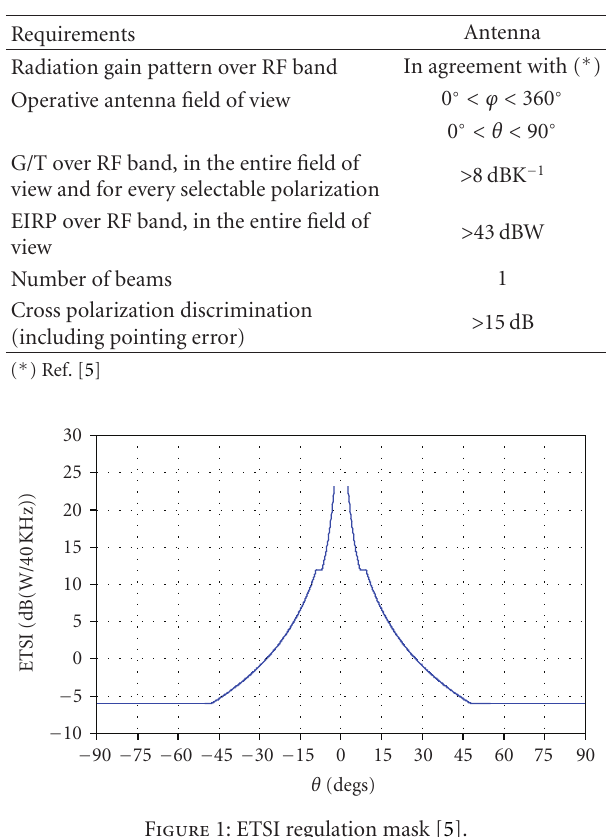
Figure 1: ETSI regulation mask [5].